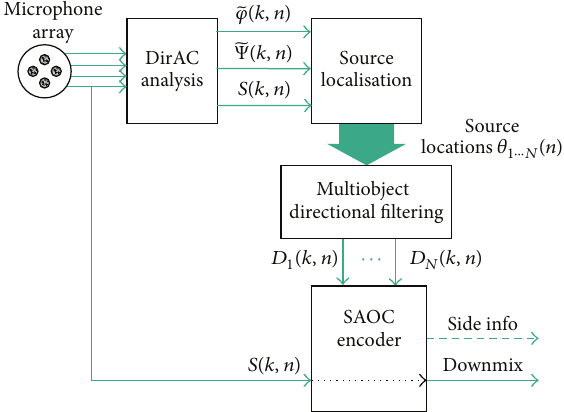
Figure 6: Signal processing architecture with DirAC encoding, source localisation, multiobject directional filtering and encoding of the directional filtering, gain functions into SAOC objects. One of the omnidirectional microphone signals is assigned as the downmix signal of